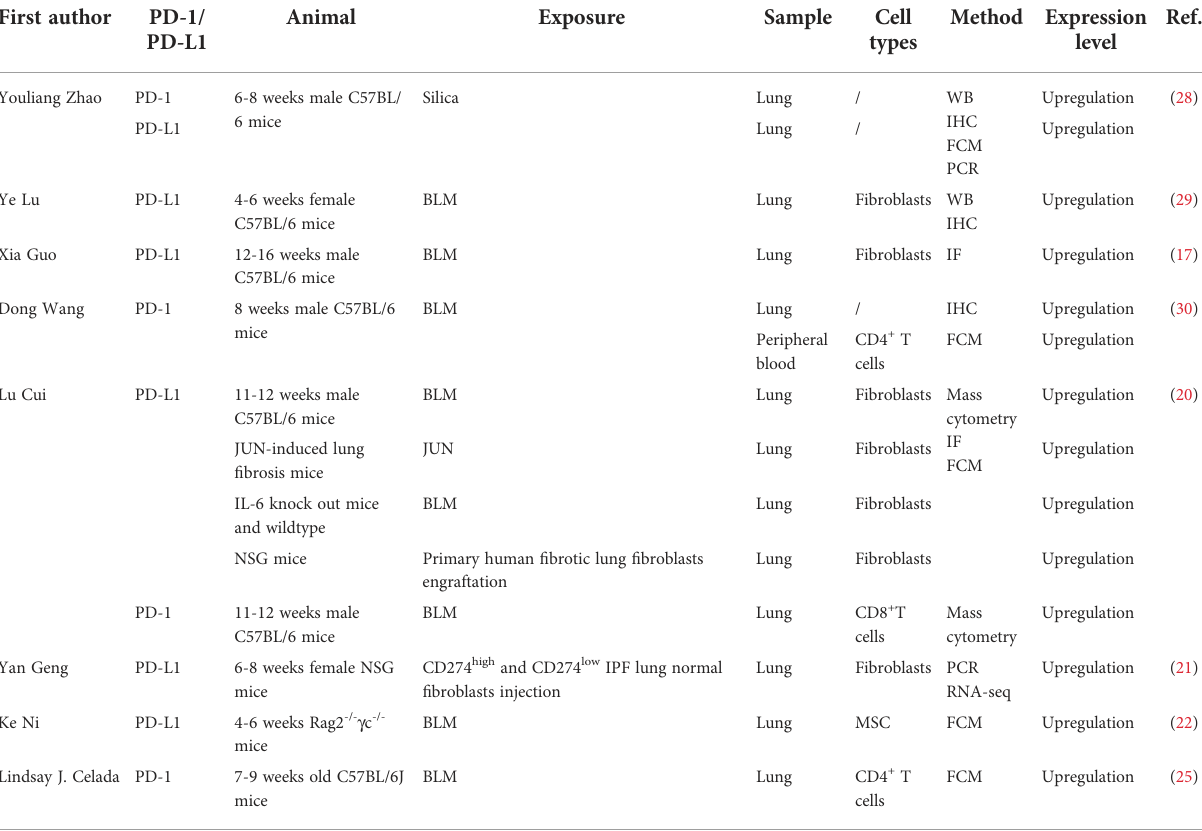
TABLE 2 The expression level of the PD-1/PD-L1 in animal